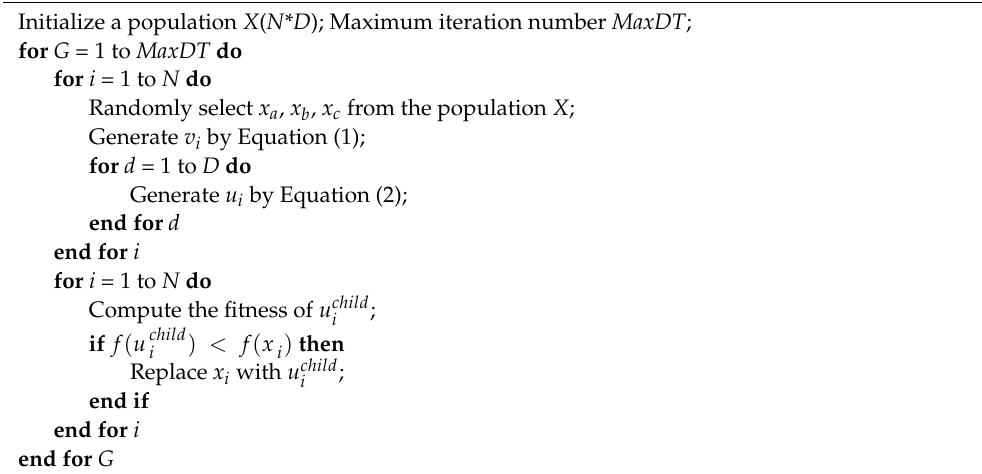
Algorithm 1 The pseudo code of